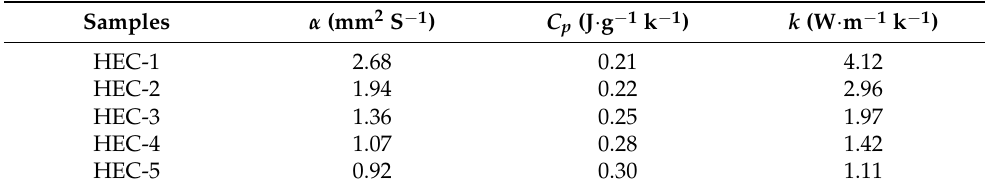
Table 2. Thermal diffusivity ( α ), specific heat capacity ( C p ), and thermal conductivity ( k ) values for the porous HECs with different amounts of pore-forming agent.